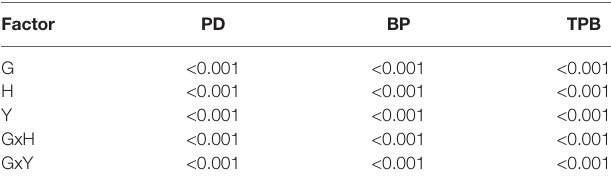
TABLE 1 | Signi fi cance (P) of main effects of snap bean genotype (G) and herbicide treatment (H), year (Y) and their interaction (GxH) on crop response in the fi eld